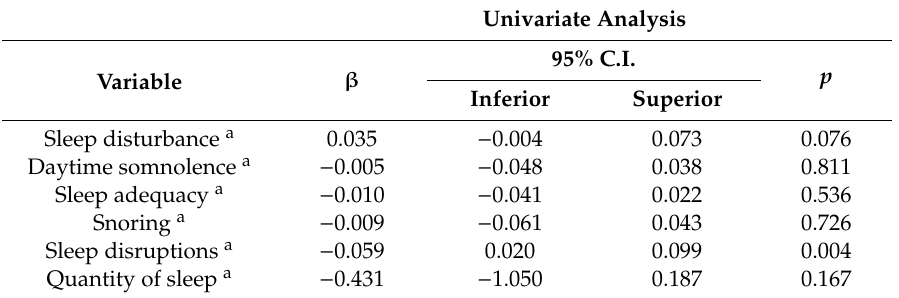
Table 6. Univariate linear regression to analyze the factors related to the intensity of